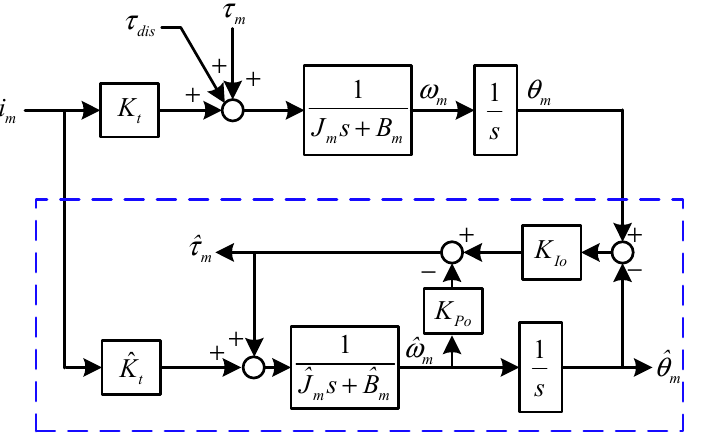
Figure 5. Disturbance observer.